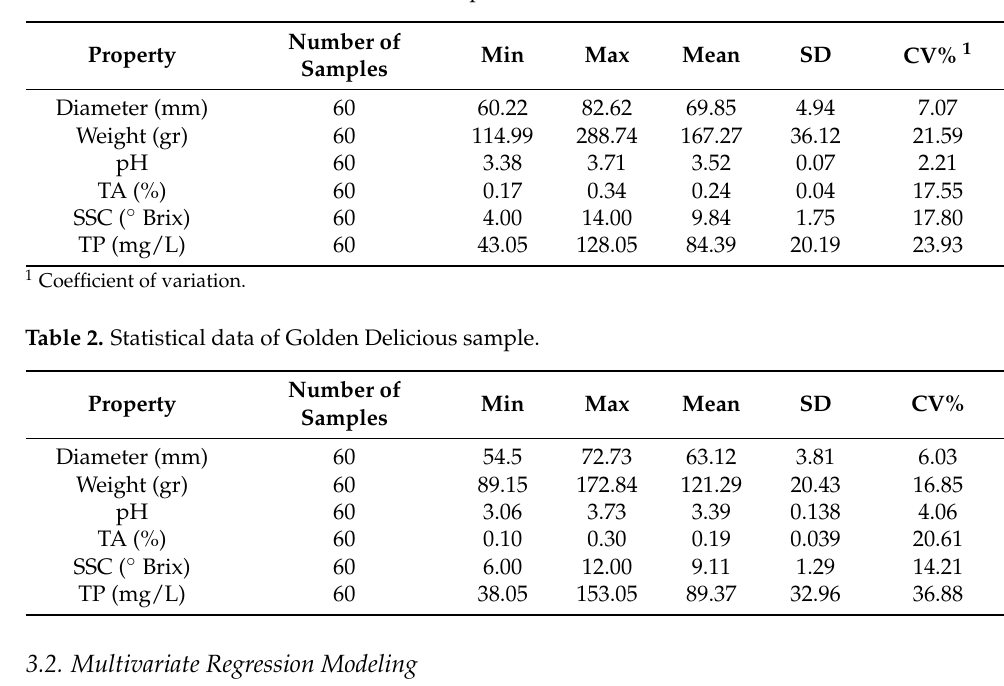
Table 1. Statistical data of Red Delicious sample.